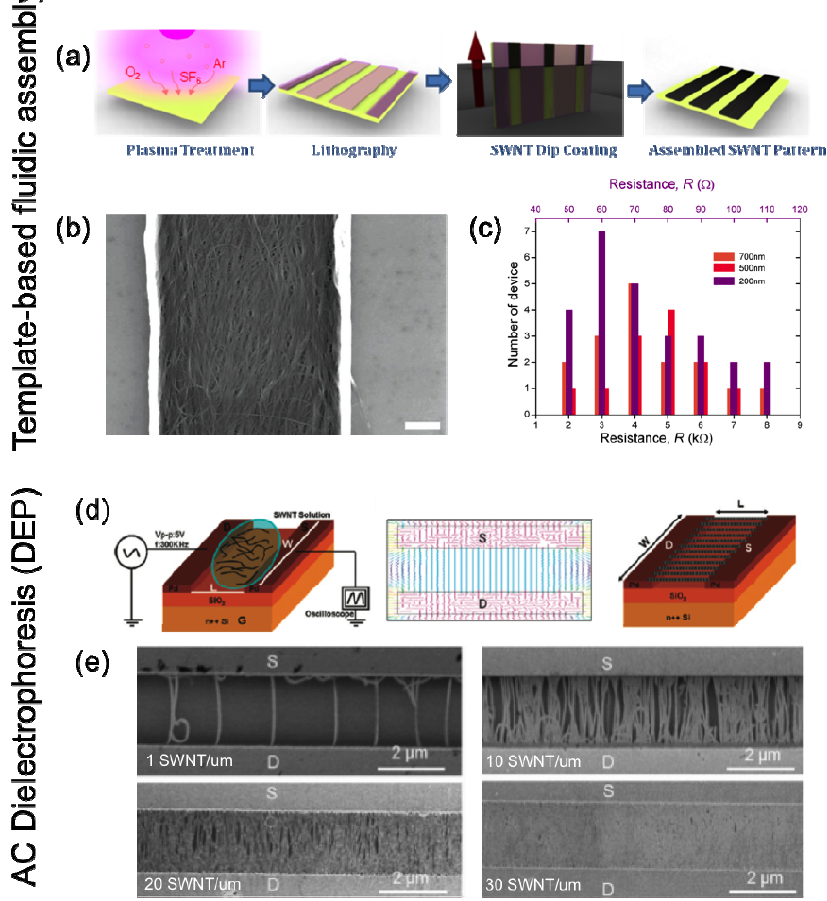
Figure 2. ( a ) Schematic of template-based fluidic assembly of high density, super aligned, sub- μ m single-wall nanotube (SWNT) parallel nanotube architectures (PNAs); ( b ) High-magnification SEM images showing the degree of alignment of the SWNTs within channel widths of 1 μ m. Scale bars = 200 nm; ( c ) Resistance histograms of SWNT-PNAs for different channel length (700, 500 and 200 nm, as labeled); ( d ) Schematic of the dielectrophoresis (DEP) assembly method; ( e ) SEM images for a